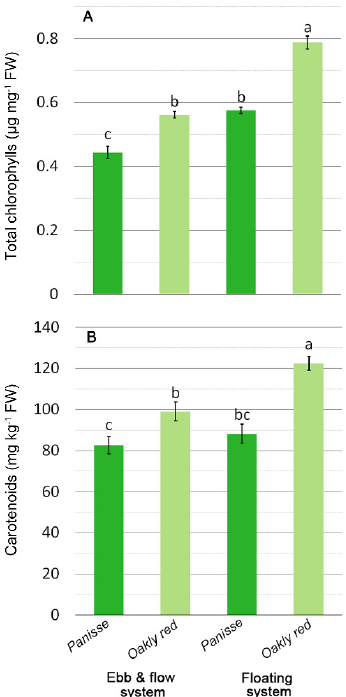
Figure 3. Effect of soilless cultivation system and genotype on total chlorophylls ( A ) and carotenoids ( B ) of oak-leaf lettuce grown in a greenhouse during the autumn. Vertical bars indicate the ± SE of mean ( n = 6) of the observed values, with different letters significantly different according to the LSD test ( α =